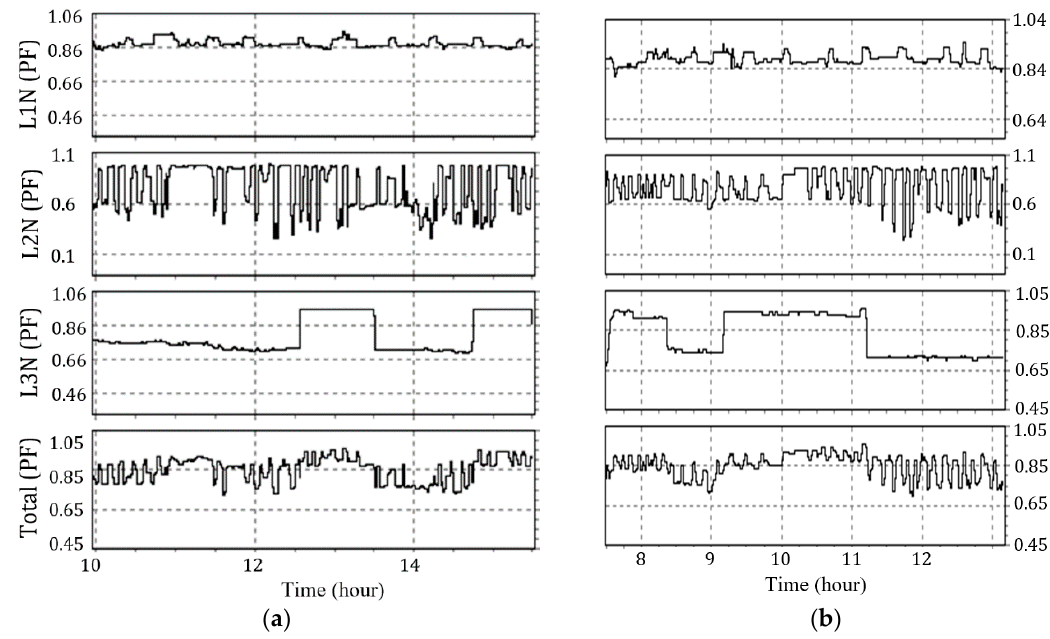
Figure 2. The load phase currents in the most unfavorable case.